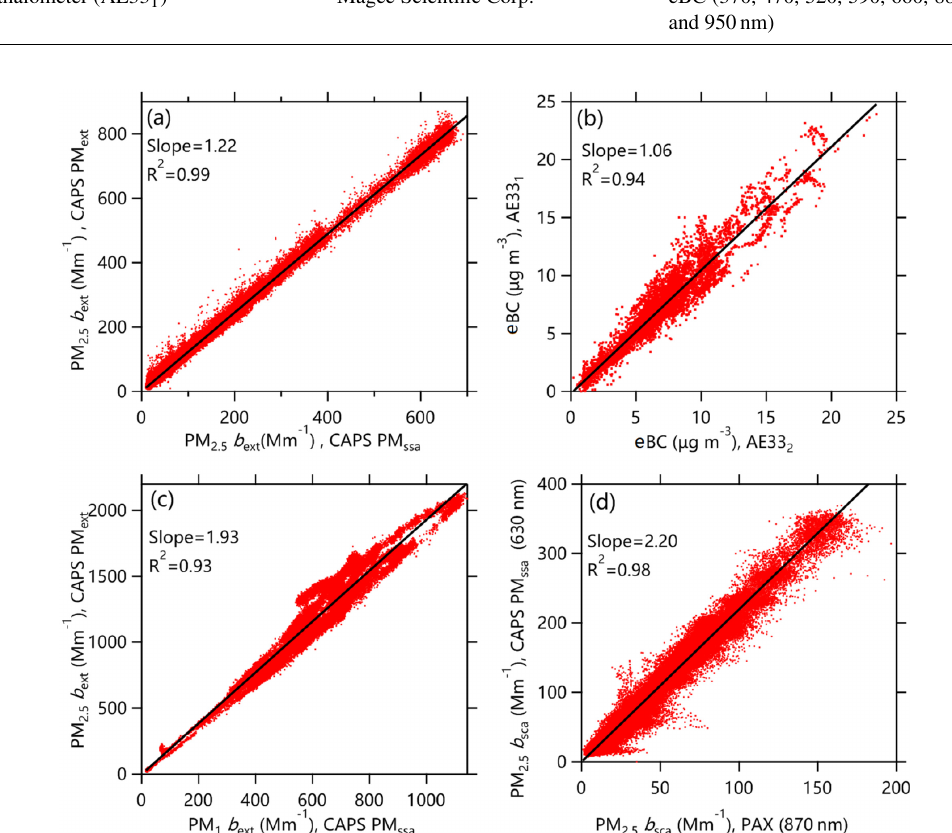
Atmos. Chem. Phys., 19, 165–179,